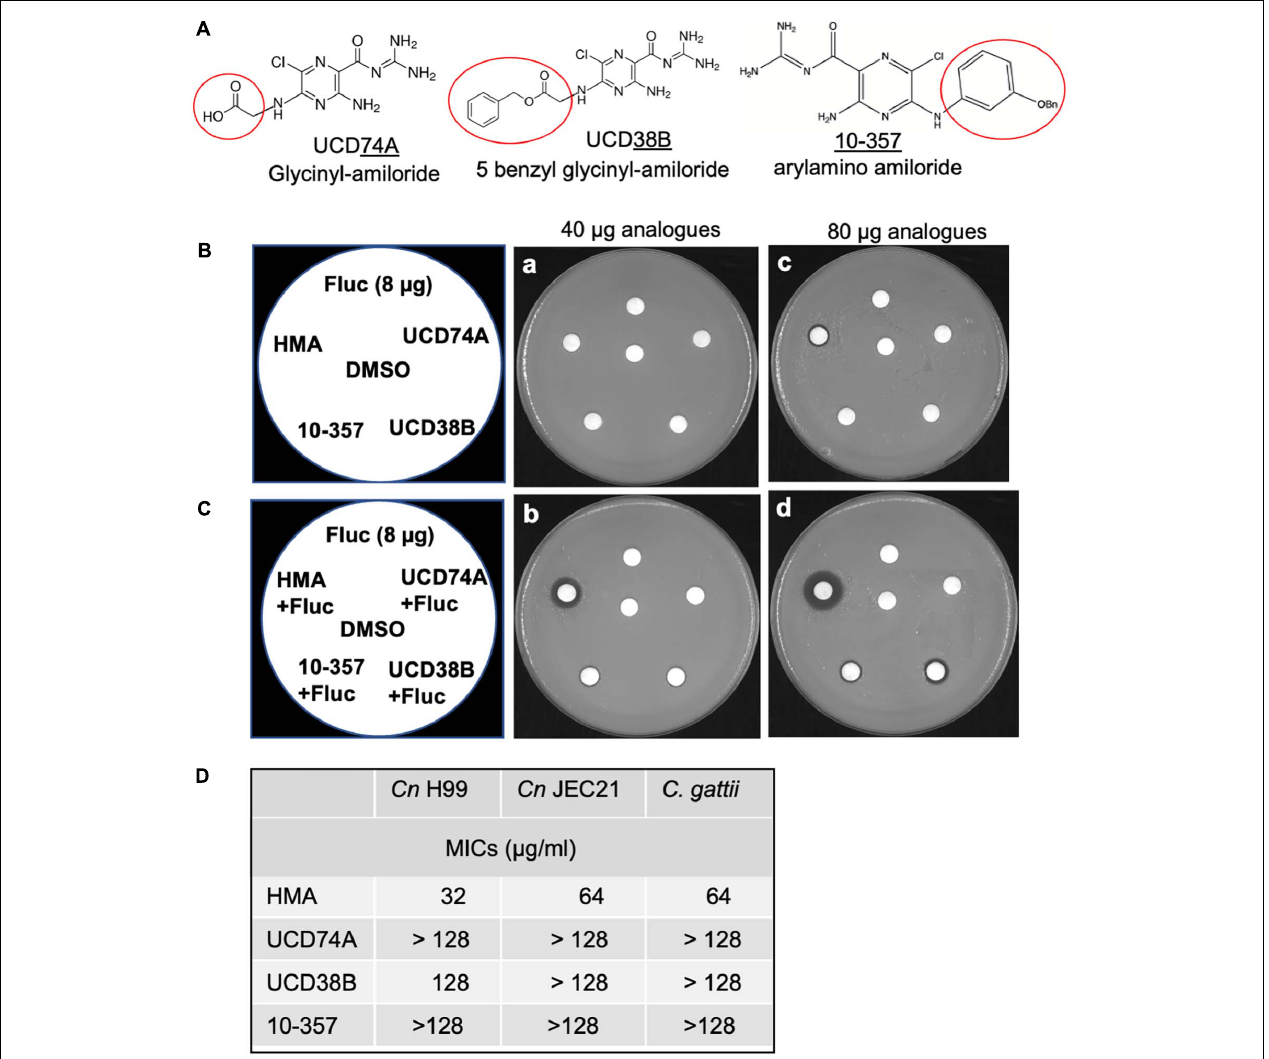
FIGURE 3 | Polar substitutions at the 5-amino group of amiloride eliminate antifungal activity. (A) Three amiloride analogs UCD38B (5-benzyl glycinyl-amiloride), UCD74A (glycinyl-amiloride), and 10-357 (arylamino amiloride, Bn, benzyl group) with polar group substitutions at the 5-amino group of the pyrazine ring (kindly provided by F. Gorin, UC Davis). (B,C) Disk diffusion assays showing susceptibility of the C. neoformans H99 strain to HMA and three other amiloride analogs at 40 and 80 µ g and fluconazole (Fluc) at 8 µ g either alone (B) or in combination with fluconazole (8 µ g) (C) . (D) Susceptibility of Cryptococcus neoformans